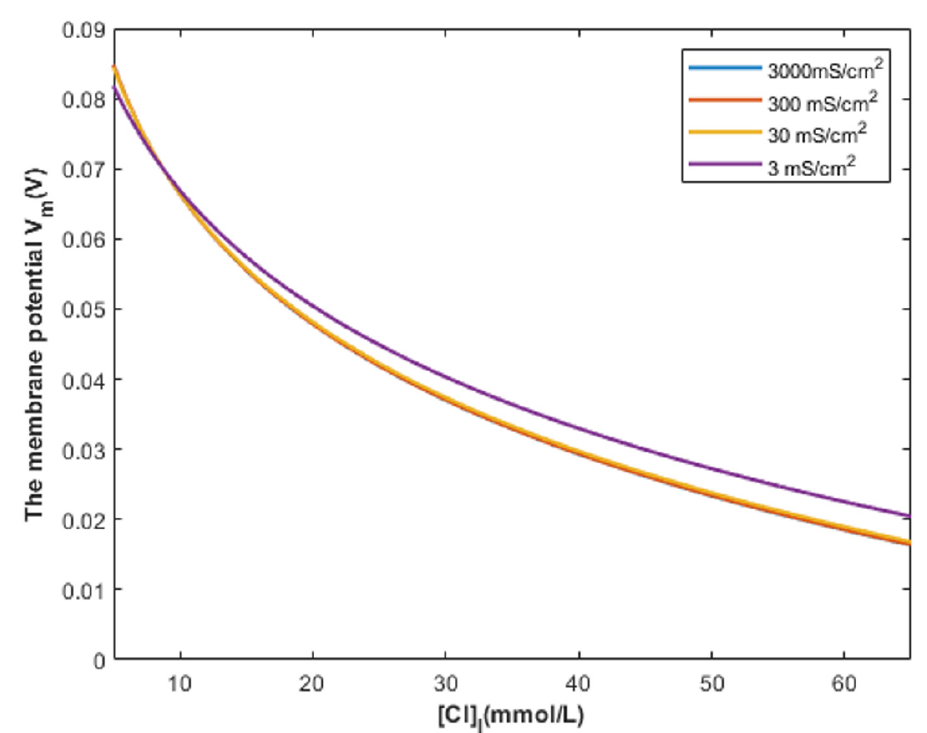
Figure 18. The figure represents the relationship between the intracellular chloride ions and the resting membrane potential under the influence of the classical transport of chloride ions through open GABA receptors at different values of membrane conductance of chloride ions.